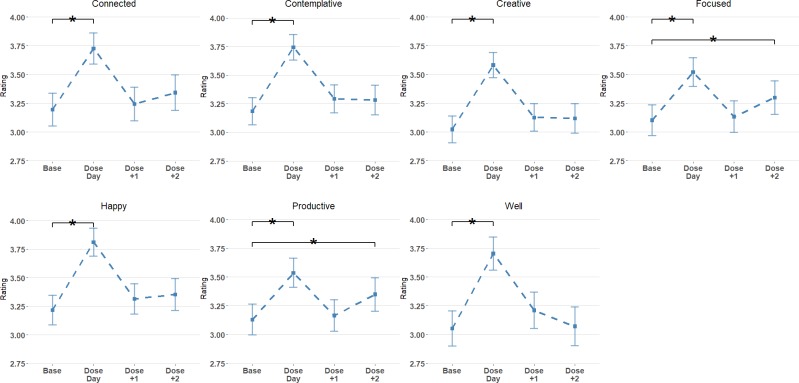
Daily ratings for each variable at Baseline, Dose Day (dosing day), Dose+1 (the day after dosing), and Dose+2 (2 days after dosing).Error bars show 95% confidence intervals. * indicates a significant difference from baseline (adjusted p < .05).